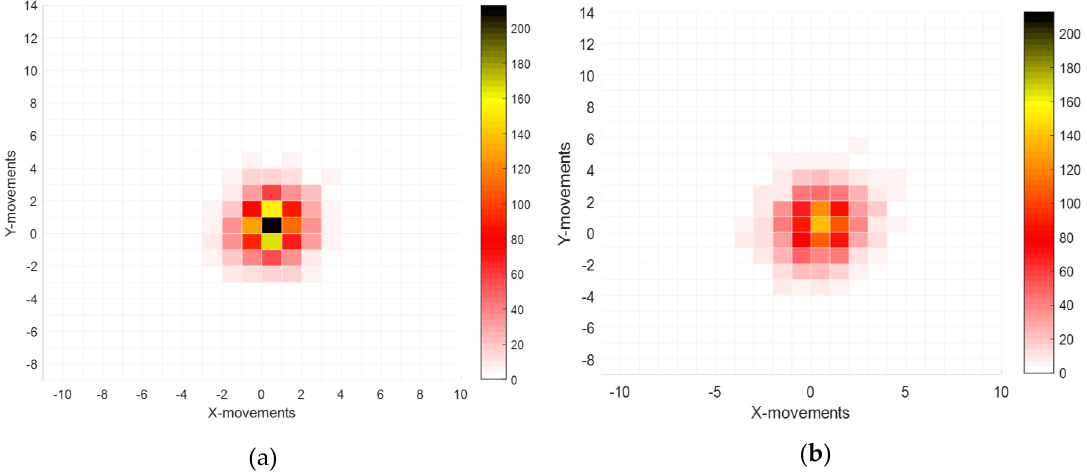
Figure 11. 2D histogram of temporal fluctuations measured at z 3 plane: ( a ) Pattern Test. ( b ) Test #3. Source: Authors.